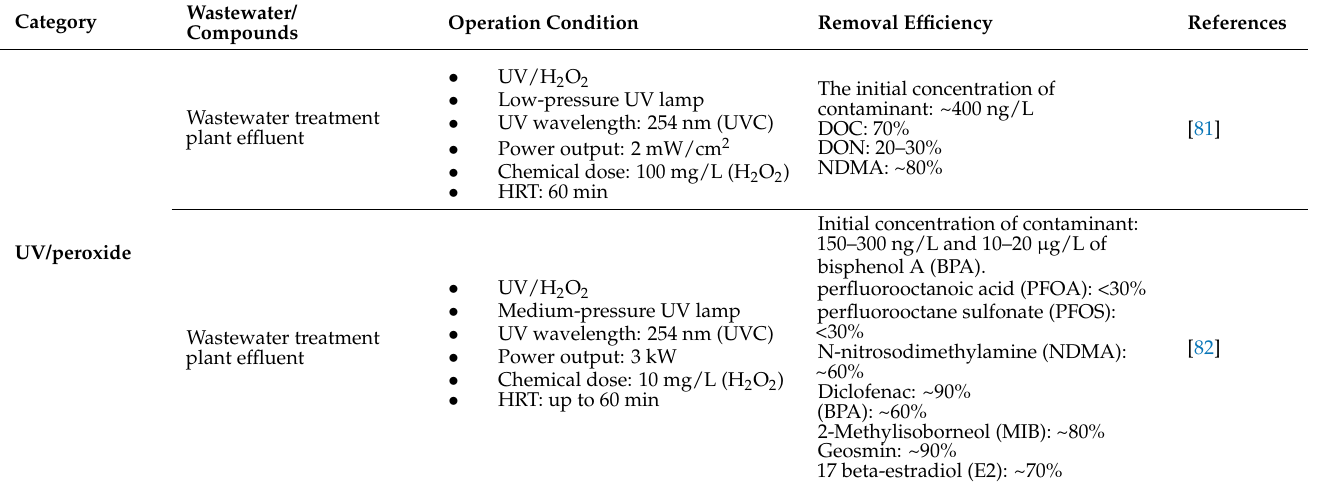
Table 4. Current application of UV/oxidant